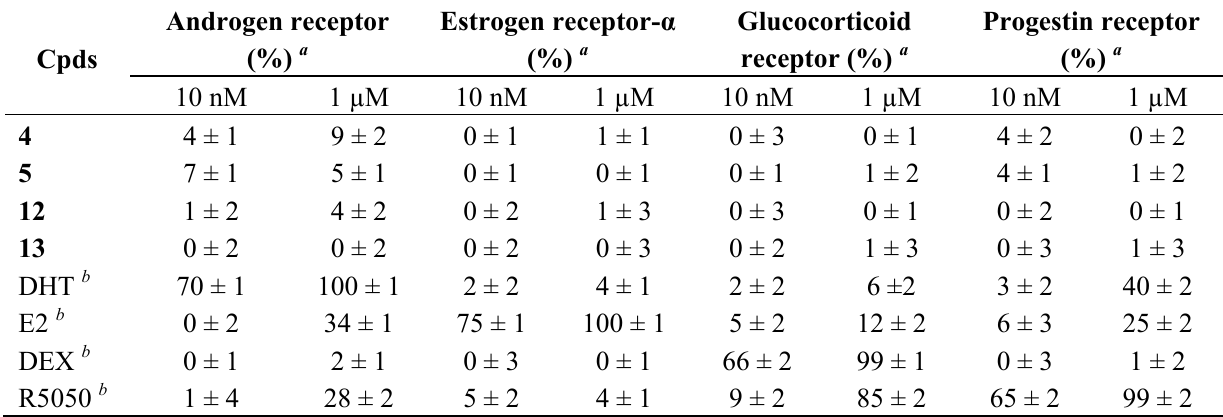
Table 3. Binding affinity (%) of compounds 4 , 5 , 12 and 13 on steroid